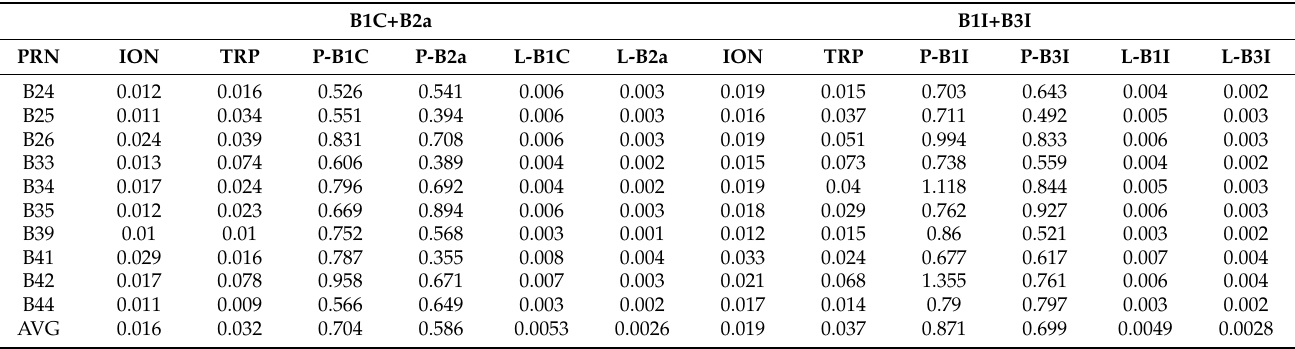
Figure 6. Comparison of average RMS of the DD solutions from different combinations of BDS-3 in WH04-HG02.